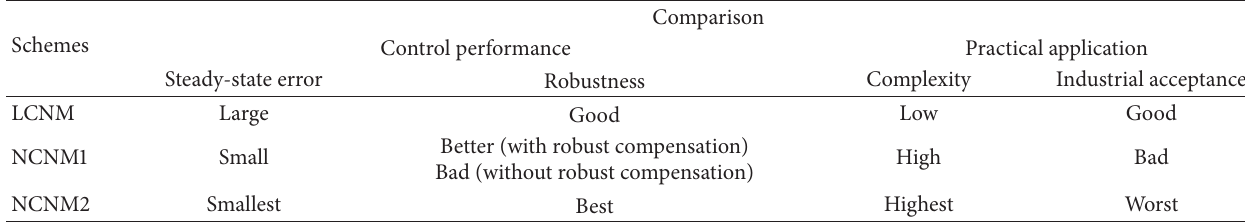
Figure 13: System responses with different pitch controllers considering parameter uncertainties. Table 1: Comparisons of different control schemes.